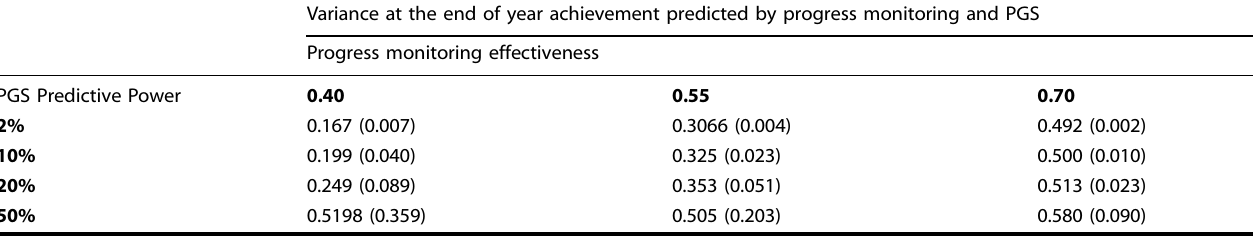
Table 1. Variance in end-of-year achievement predicted by progress monitoring and PGS.